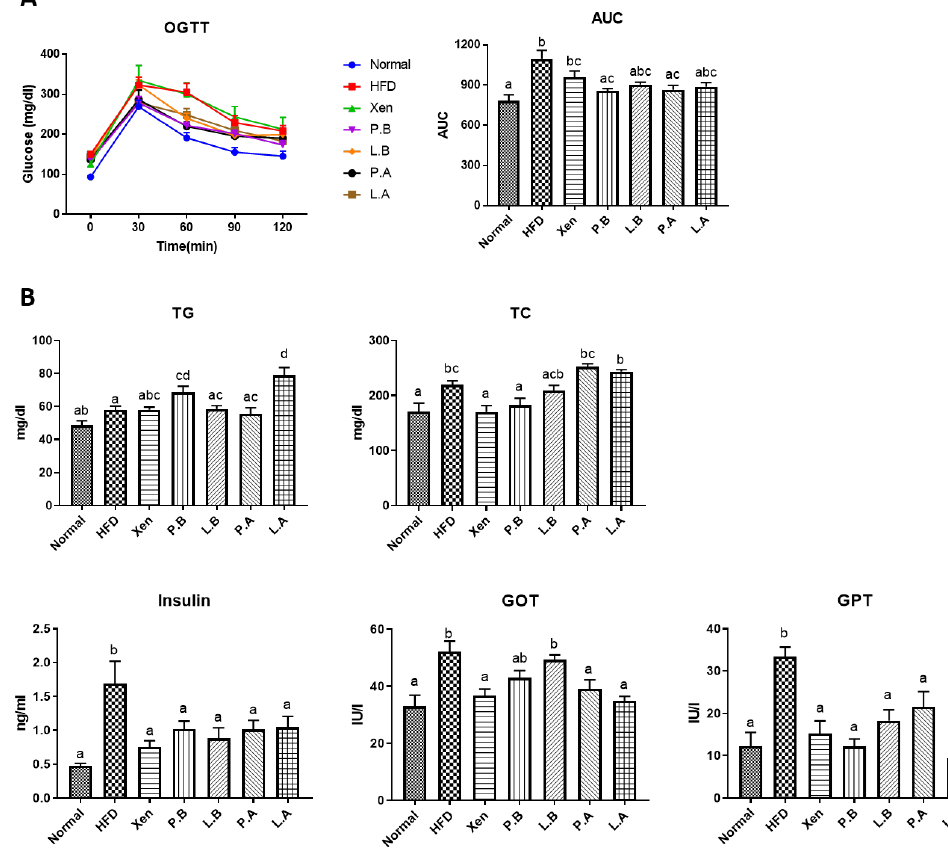
Figure 2. Oral administration of A. muciniphila strains improved the obesity parameters in the high-fat diet-induced mice. ( A ) Serum glucose levels at different time points in the oral glucose tolerance test (OGTT). Areas under the curve (AUCs) were constructed, as described in the Materials and Methods Section. ( B ) Serum levels of triglyceride (TG), total cholesterol (TC), insulin, glutamic ox-aloacetic transaminase (GOT) and glutamic pyruvic transaminase (GPT) were assessed to determine the lipid profile, insulin sensitivity, glucose homeostasis and liver function. The data are expressed as means ± SD; the differences were statistically evaluated using one-way ANOVA. Means without a common letter significantly differ, p < 0.05. HFD, high-fat diet; Xen, orlistat, P.B, pasteurized BAA-835; L.B, live BAA-835; P.A, pasteurized A. muciniphila ; L.A, live A. muciniphila .